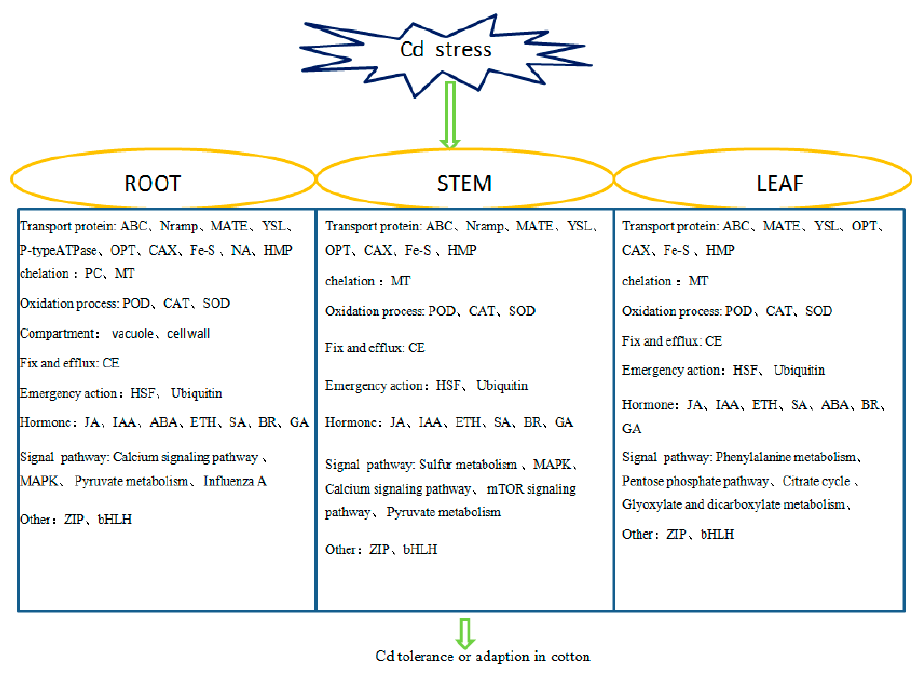
Figure 13. Key factors of Cd tolerance in roots, stems, and leaves of cotton.